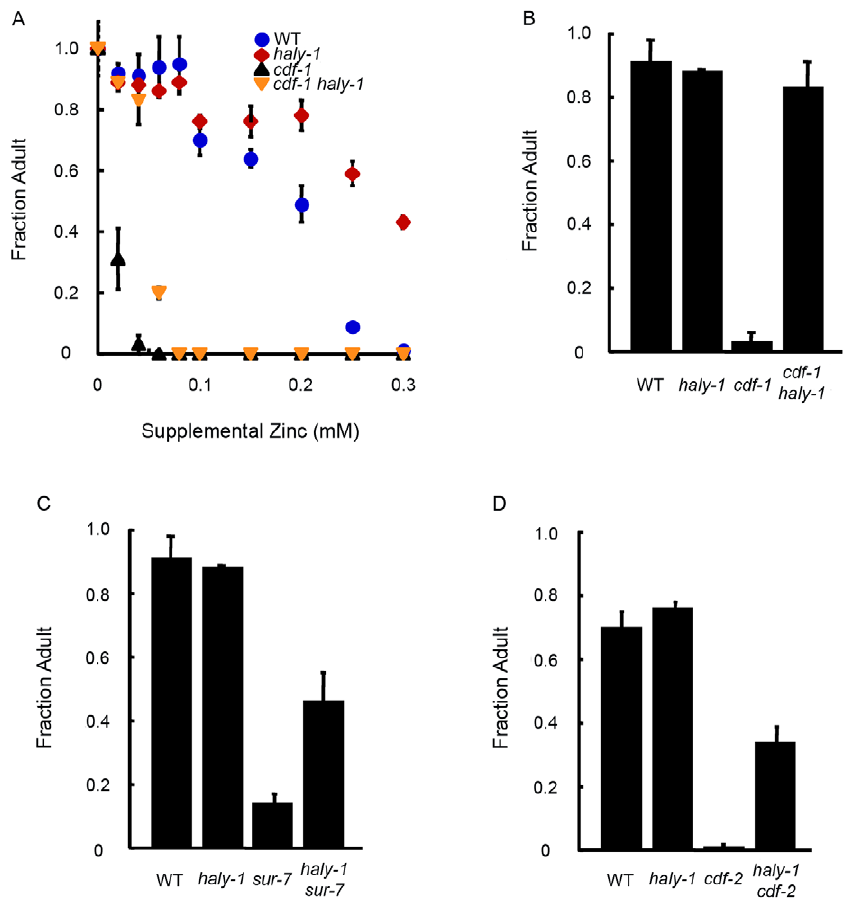
Figure 4. haly-1(am132) causes zinc resistance in multiple genetic backgrounds. (A) Wild-type, haly-1(am132 ), cdf-1(n2527) and cdf-1(n2527) haly-1(am132) hermaphrodites were synchronized at the L1 stage and cultured on NAMM supplemented with zinc. The fraction of worms that grew to adulthood over seven days was monitored; the data were normalized by setting the value at 0 mM supplemental zinc equal to 1.0. Each point indicates mean value 6 SE (n=3 replicates with 50 worms per replicate). The fraction adult for cdf-1(n2527) haly-1(am132) was significantly different than cdf-1(n2527) and haly-1(am132) at 0.06 mM supplemental zinc (p , 0.05). (B) The data from panel A at 0.04 mM supplemental zinc are displayed as a bar graph. The fraction adult for cdf-1(n2527) haly-1(am132) was significantly higher than cdf-1(n2527) (p=0.0009). (C) Wild-type, haly-1(am132) , sur-7(ku119) and haly-1(am132) sur-7(ku119) hermaphrodites were analyzed as described above at 0.04 mM supplemental zinc. Bars indicate mean values 6 SE. The fraction adult for haly-1(am132) sur-7(ku119) was significantly different than sur-7(ku119) and haly-1(am132) (p , 0.02). (D) Wild-type, haly-1(am132) , cdf-2(tm788) and haly-1(am132) cdf-2(tm788) hermaphrodites were analyzed as described above at 0.1 mM supplemental zinc. Bars indicate mean values 6 SE. The fraction adult for haly-1(am132) cdf-2(tm788) was significantly different than cdf-2(tm788) and haly-1(am132) (p , 0.003).